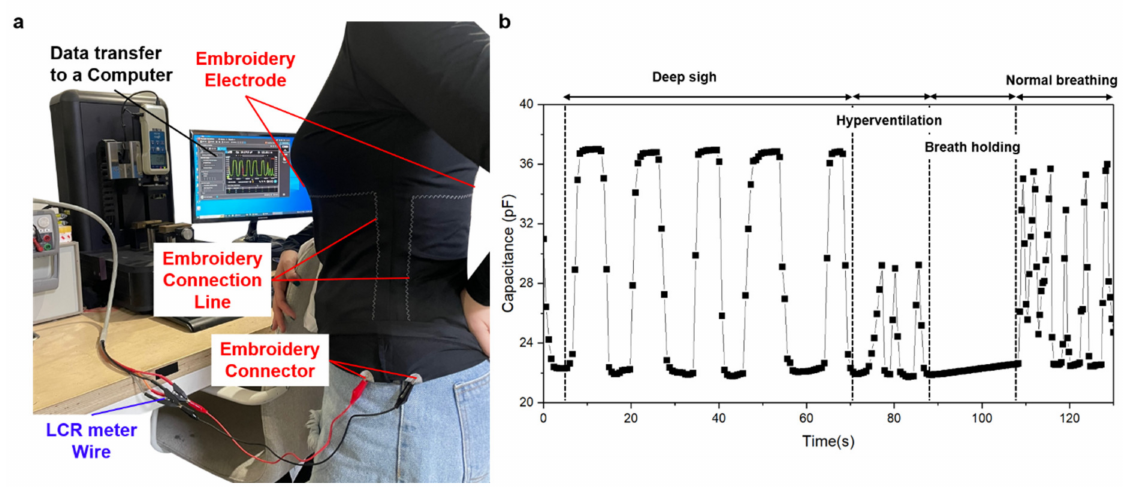
Figure 15. Measurement of respiratory capacitance sensors in clothing. ( a ) Measurement setup for the proposed capacitance respiratory sensor clothing on the body; ( b ) changes in the capacitance according to the breathing pattern after